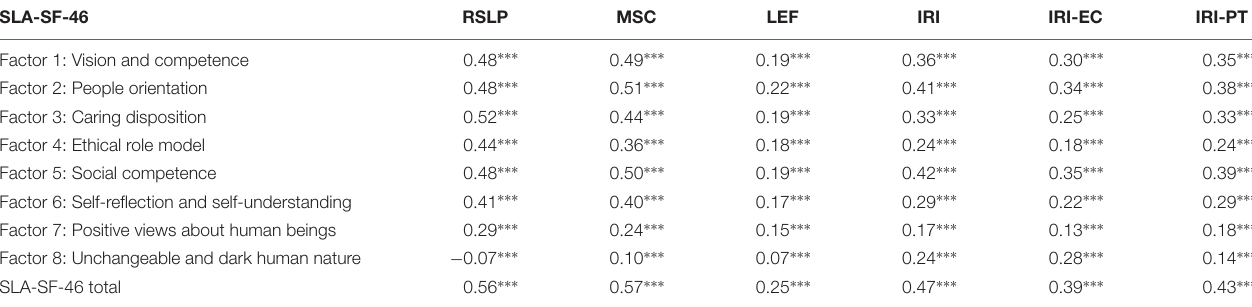
TABLE 8 | Correlations between SLA-SF-46 and external criterion scales. SLA-SF-46